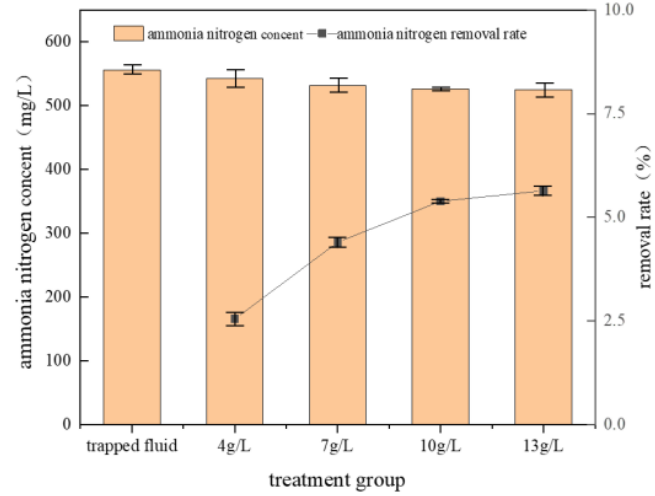
Figure 6. Effects of biochar absorption on ammonia nitrogen.